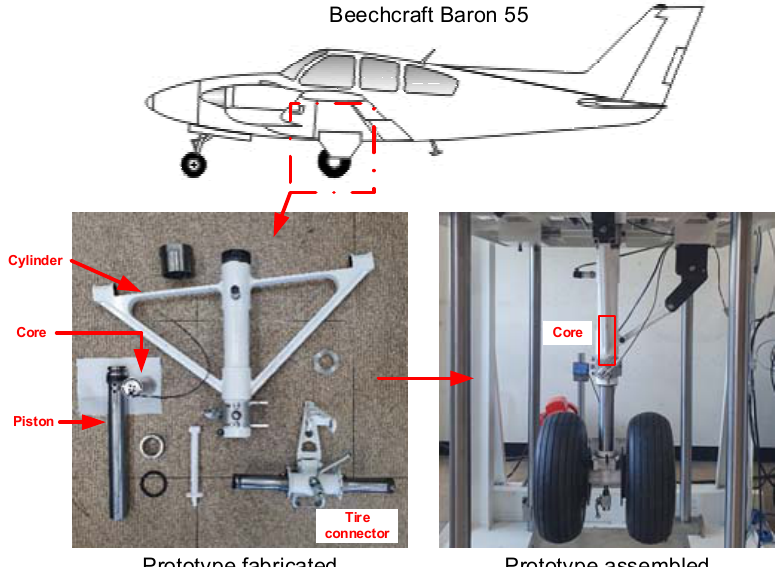
Figure 5. MR damper landing gear [34].